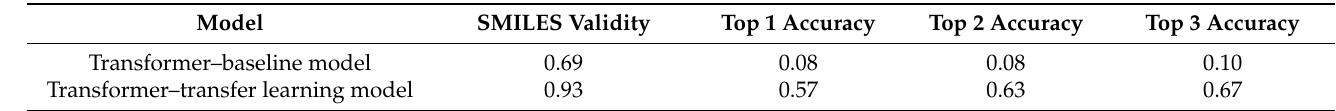
Table 4. Transformer–baseline and transformer–transfer learning models’ performance on test da- tasets.